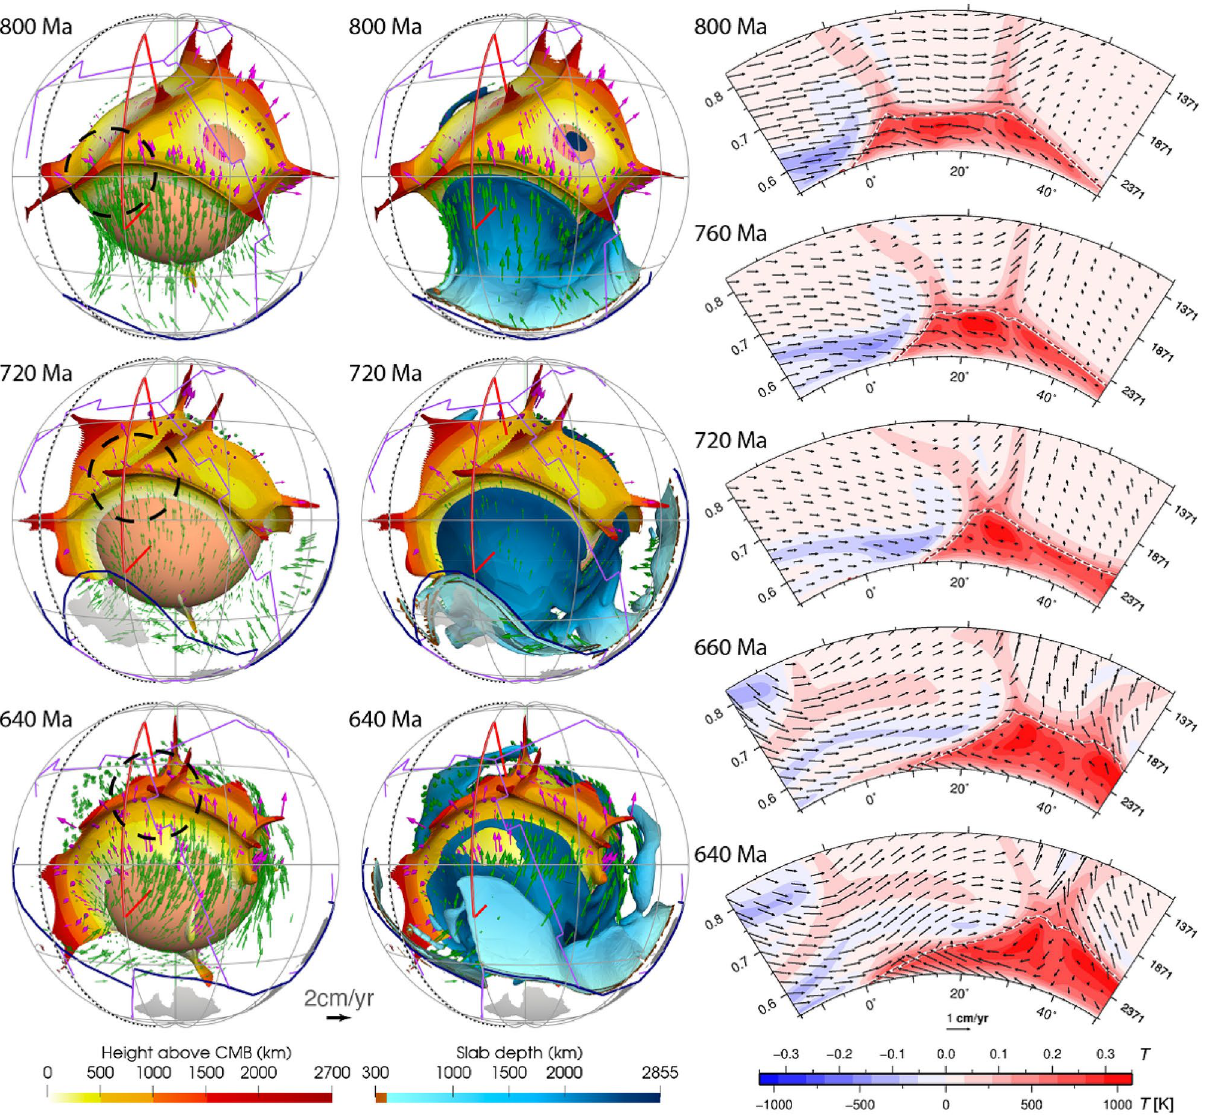
Figure 6. Plume migration on top of the superocean thermochemical structure between 800 and 640 Ma. The left panel shows the thermochemical structures. The middle panel shows both the thermochemical structures and slabs. The dashed black meridian in the left and middle panels denotes longitude 180º. The right panel shows temperature anomaly (temperature field with layer average removed) along a North–South-trending cross-section (red lines in the left and middle panels). Symbols are as in Fig. 2. This figure was created using the Generic Mapping Tools version 4.5.5 (https:// www. gener ic- mappi ng- tools. org/) 85 and ParaView version 5.8.1 (https:// www. parav iew. org/) 86